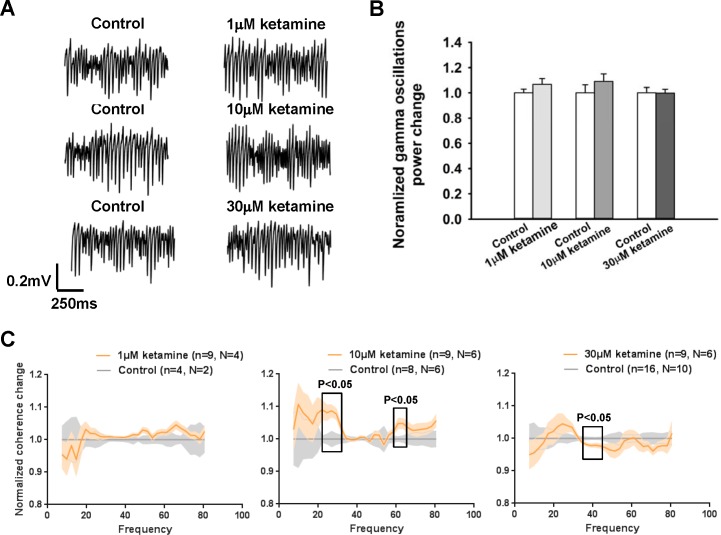
Ketamine did not affect the power of gamma oscillations but affected CA3-CA1 coherence under interface recording configuration.A, Representative field potential recordings in CA3 from control and different ketamine concentration groups after 90 min of 100 nM kainate treatment. Ketamine was applied 60min after kainate application. B, group data of normalized gamma band change in CA3 region with or without ketamine treatment. C, group data of normalized CA3-CA1 coherence change with or without ketamine treatment. 1 μM ketamine and its control, left; 10 μM ketamine and its control, middle; 30 μM ketamine and its control, right. All data are expressed as mean ± SEM.